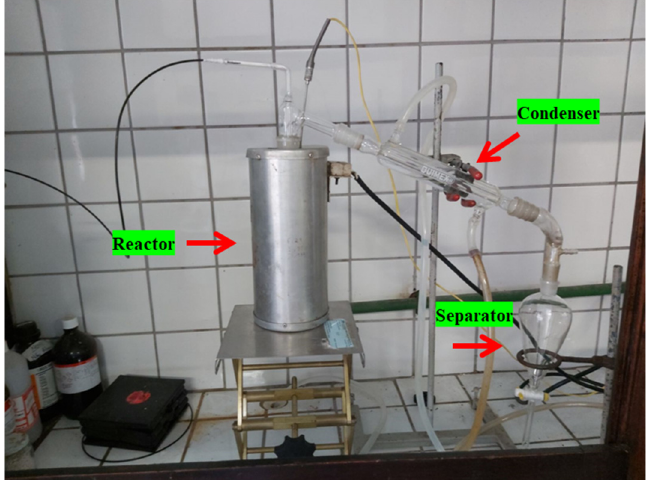
Figure 5. Experimental apparatus (glass reactor in laboratory scale).